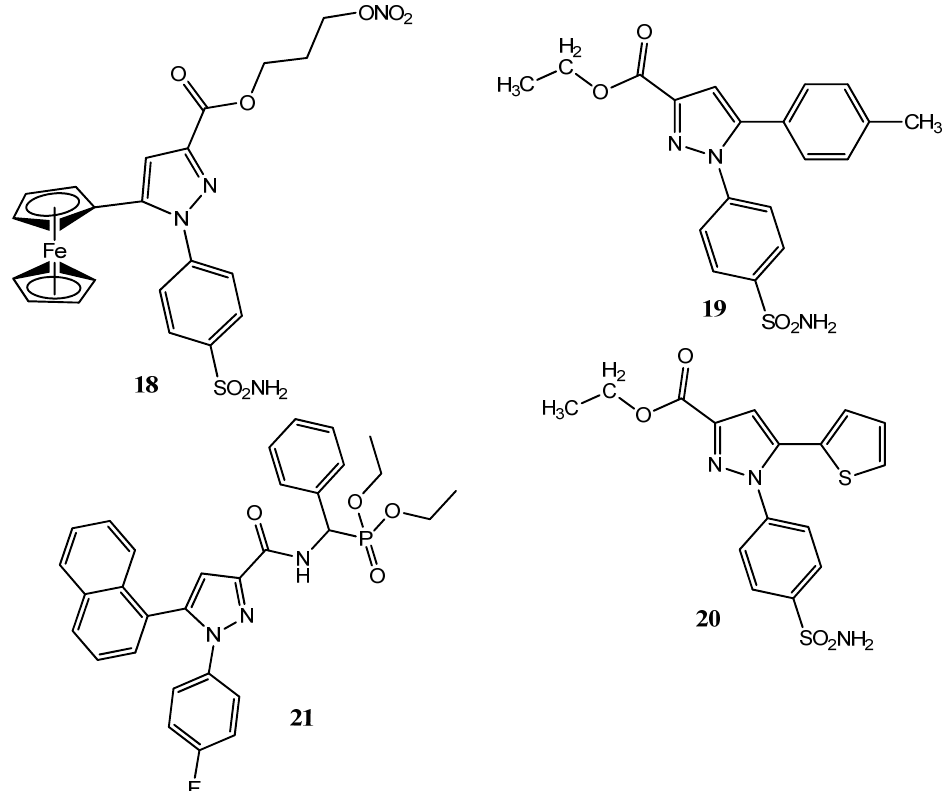
Figure 4. Pyrazole derivatives with ferrocene ( 18 ), ester ( 19 , 20 ), and aminophosphonyl ( 21 )